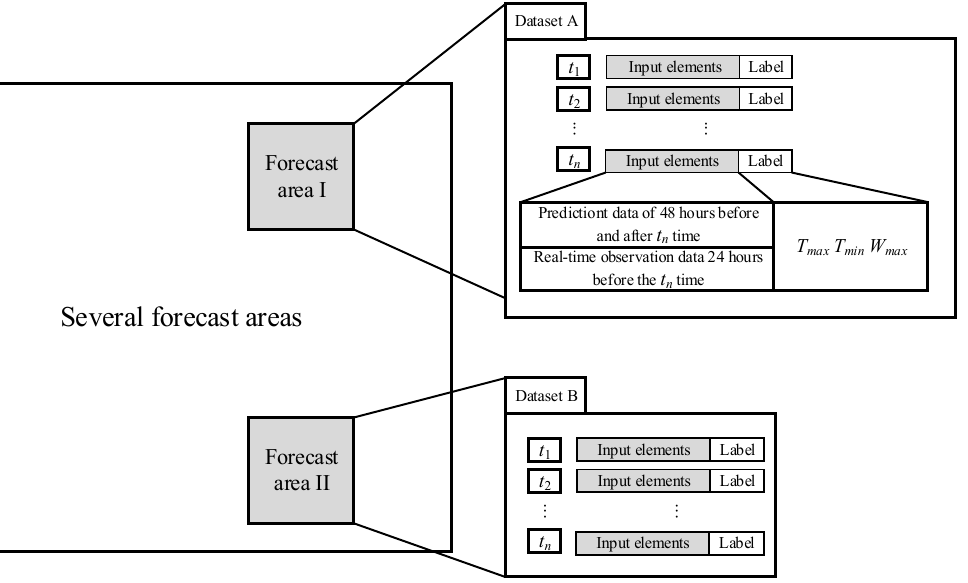
Figure 4. Schematic diagram of dataset composition.